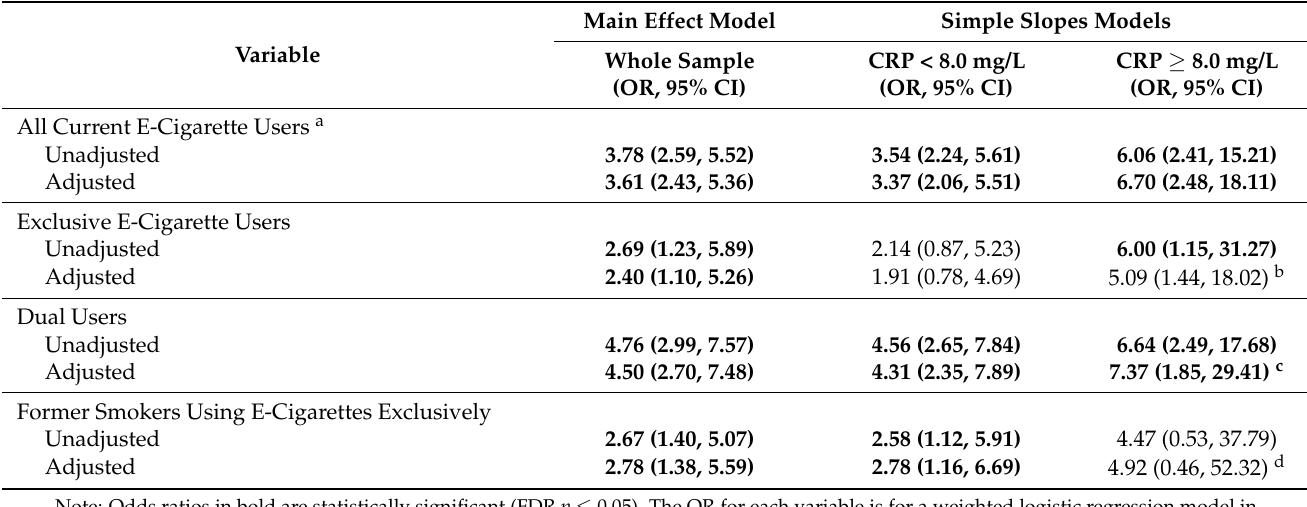
Table 4. Odds of Depression in Multivariable Analysis Among Different Categories of E-cigarette Users and Levels of CRP. Main Effect Model Simple Slopes Variable